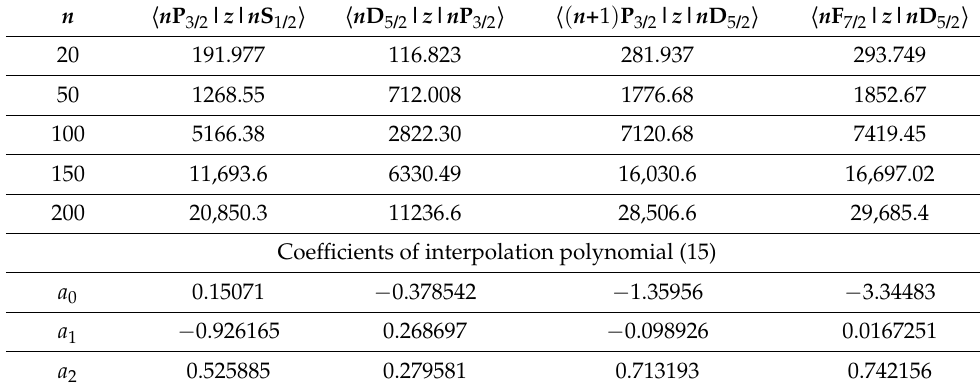
Table 8. The same as in Table 7, for Na atoms. The corresponding transition frequencies are presented in Table